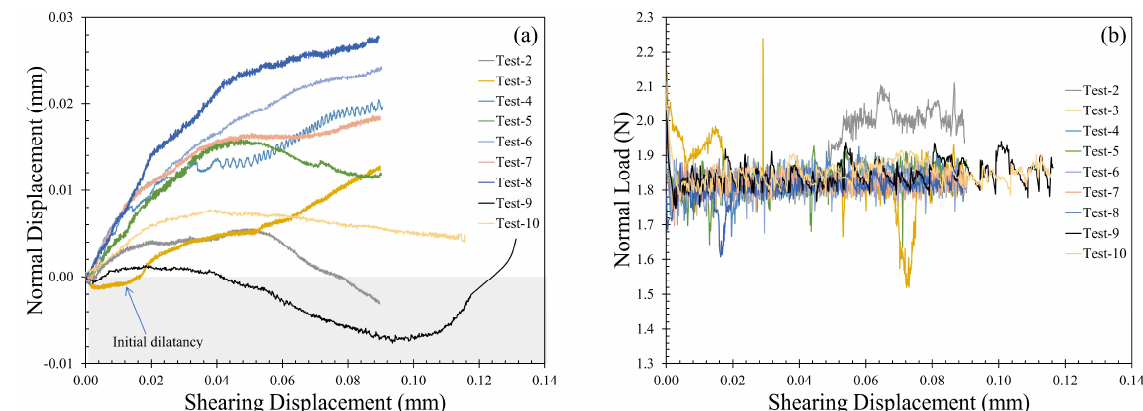
Figure 7. Variation of ( a ) normal displacement and ( b ) normal load against shearing displacement during sliding.